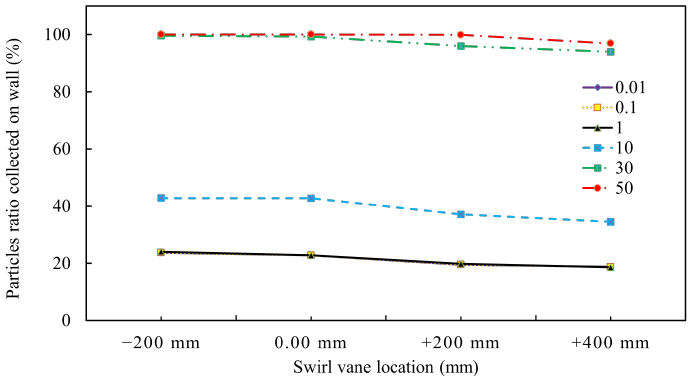
Figure 17. Effect of vane location with different particle sizes.